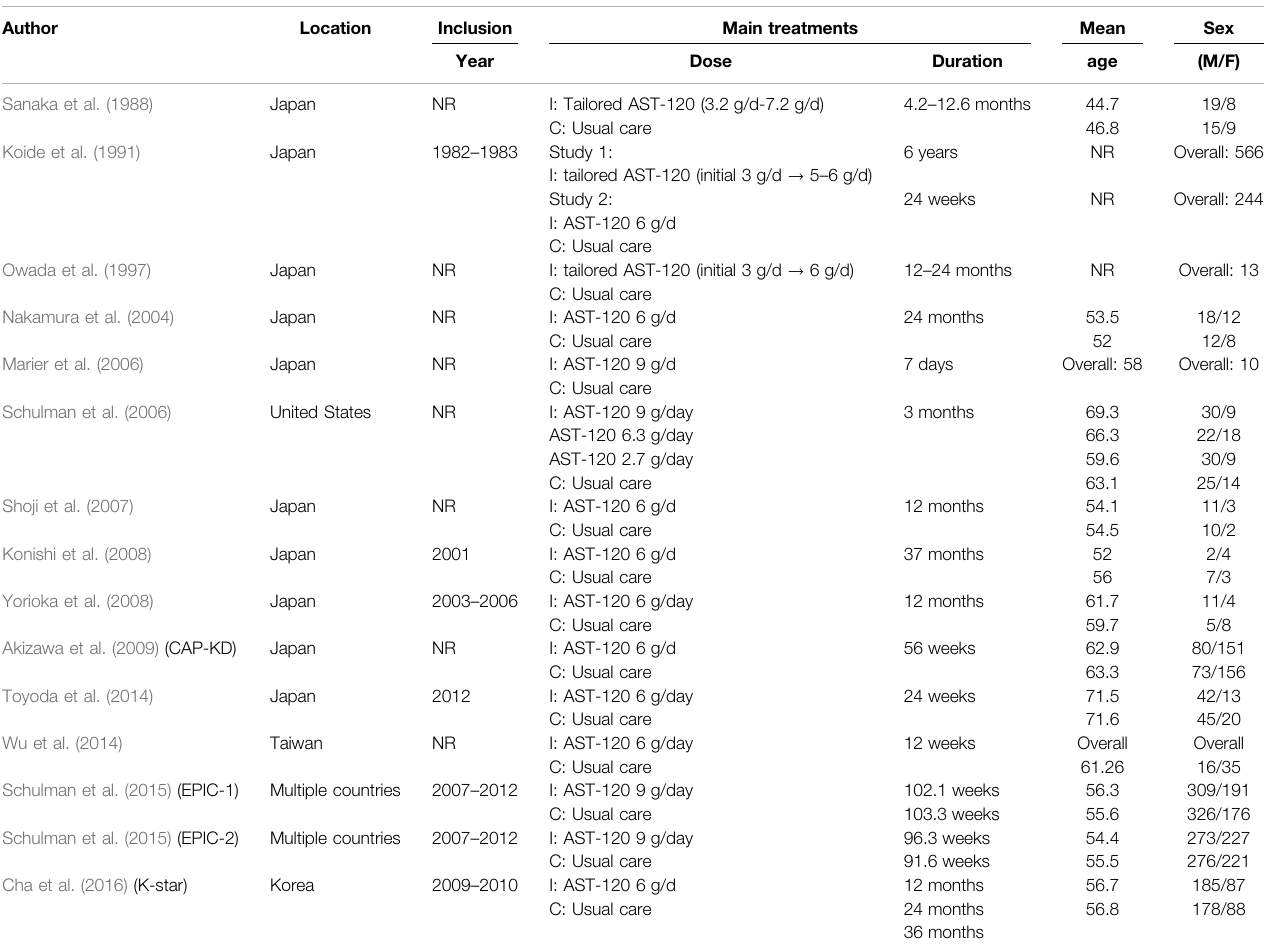
TABLE 1 | Characteristics of the included randomized controlled